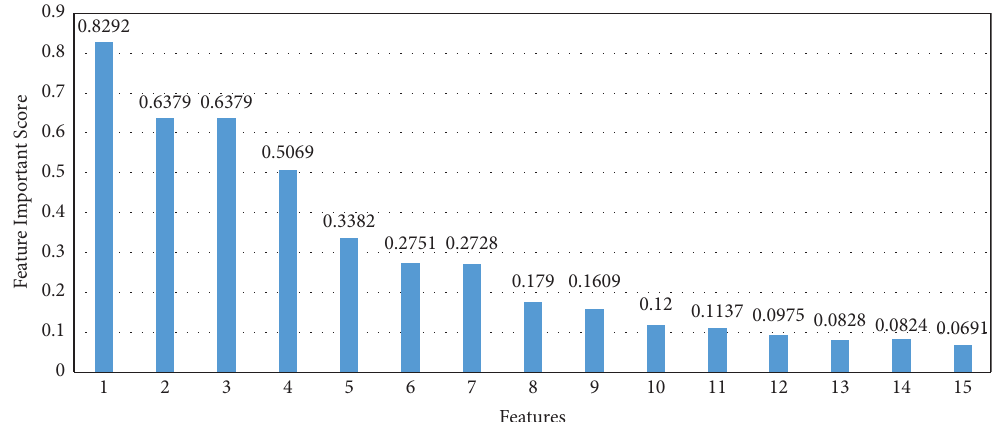
Figure 2: RF feature importance evaluation.